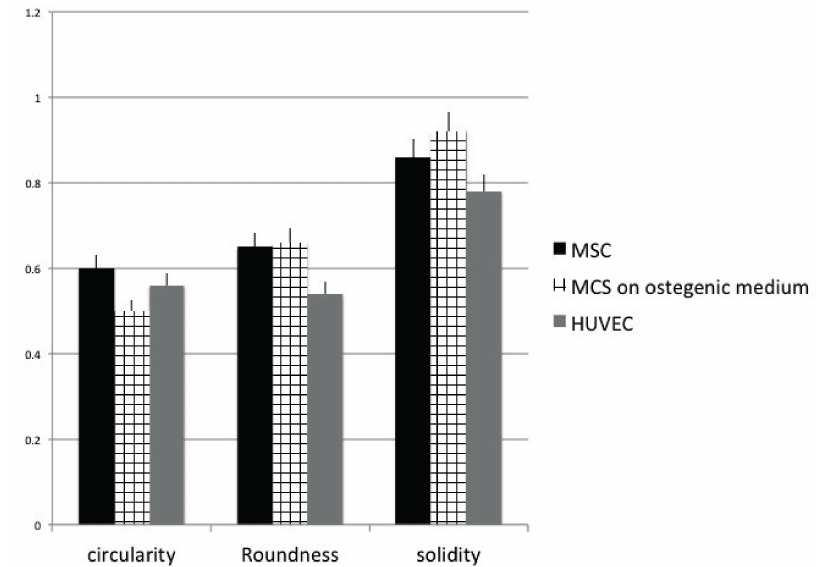
Figure 5. Analysis of the circularity, roundness, and solidity cell shape parameters after 14 days of culture onto OGI surfaces. MSC cultured in presence of nondifferentiative medium: (black bars), osteoinductive medium (squared bars); HUVEC (grey